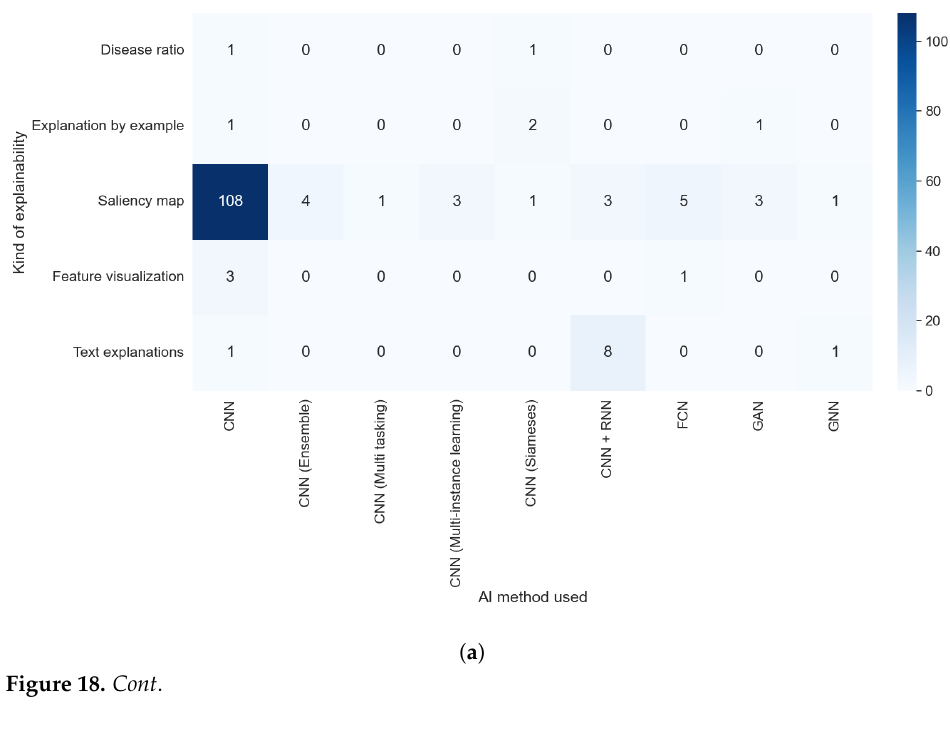
Figure 17. Heat maps comparing the results of RQ1 and RQ7. ( a ) In absolute values; ( b ) normalized results by column, values in percentages.